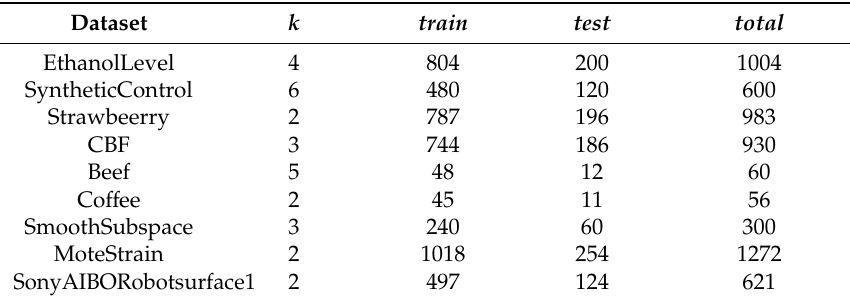
Table 1. Review of raw 9 UCR public